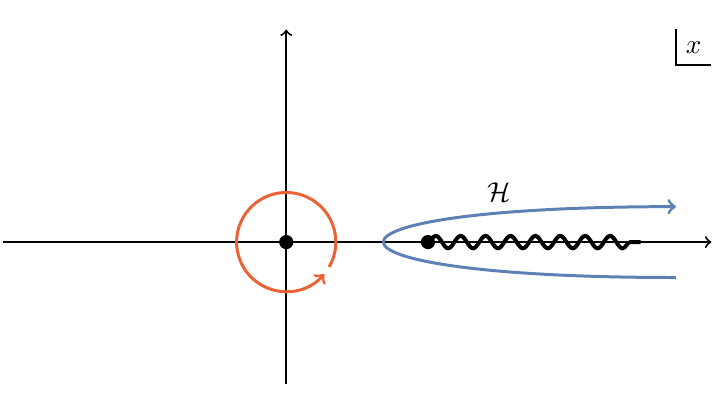
Figure 3 . Contour deformation to the Hankel contour H